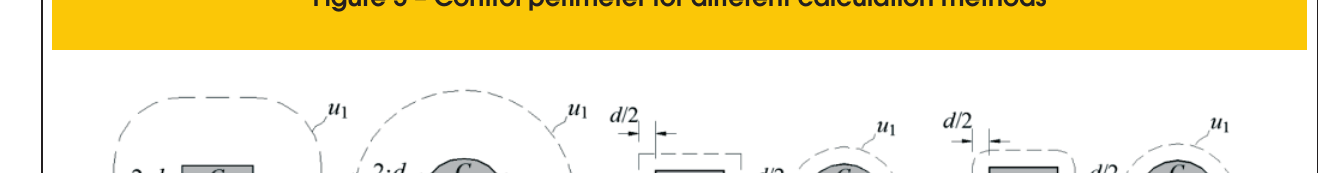
Figure 5 – Control perimeter for different calculation